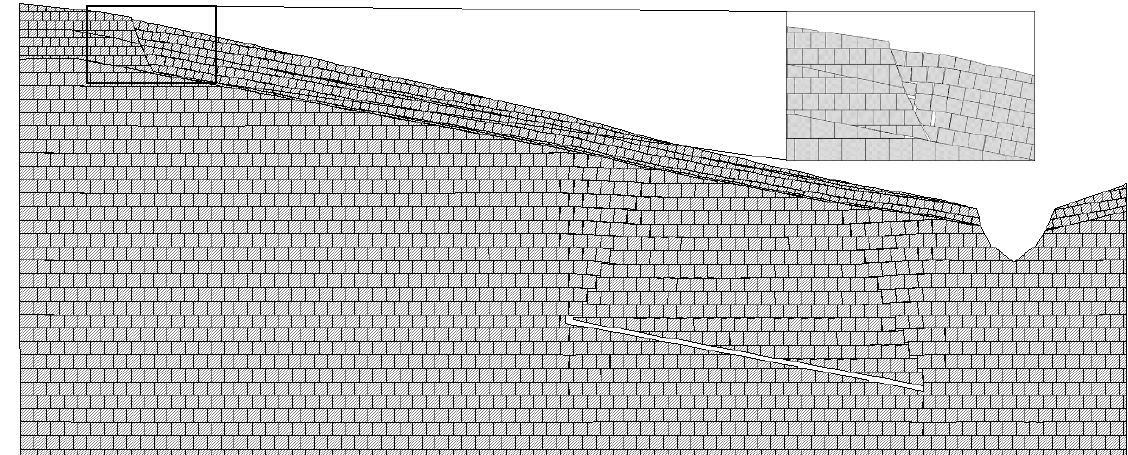
Figure 6. Iterative 10,000-step numerical simulation results.